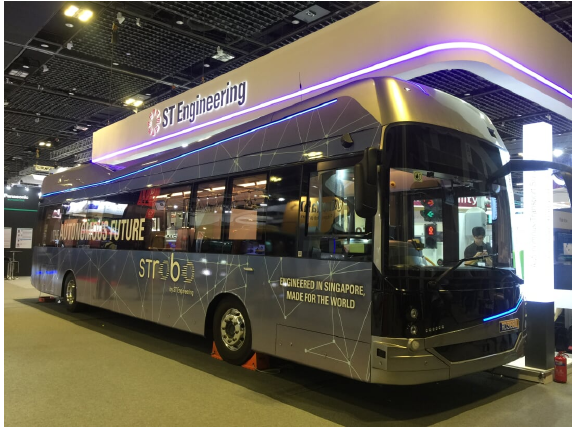
Figure 1. One of our 12-m-long autonomous buses